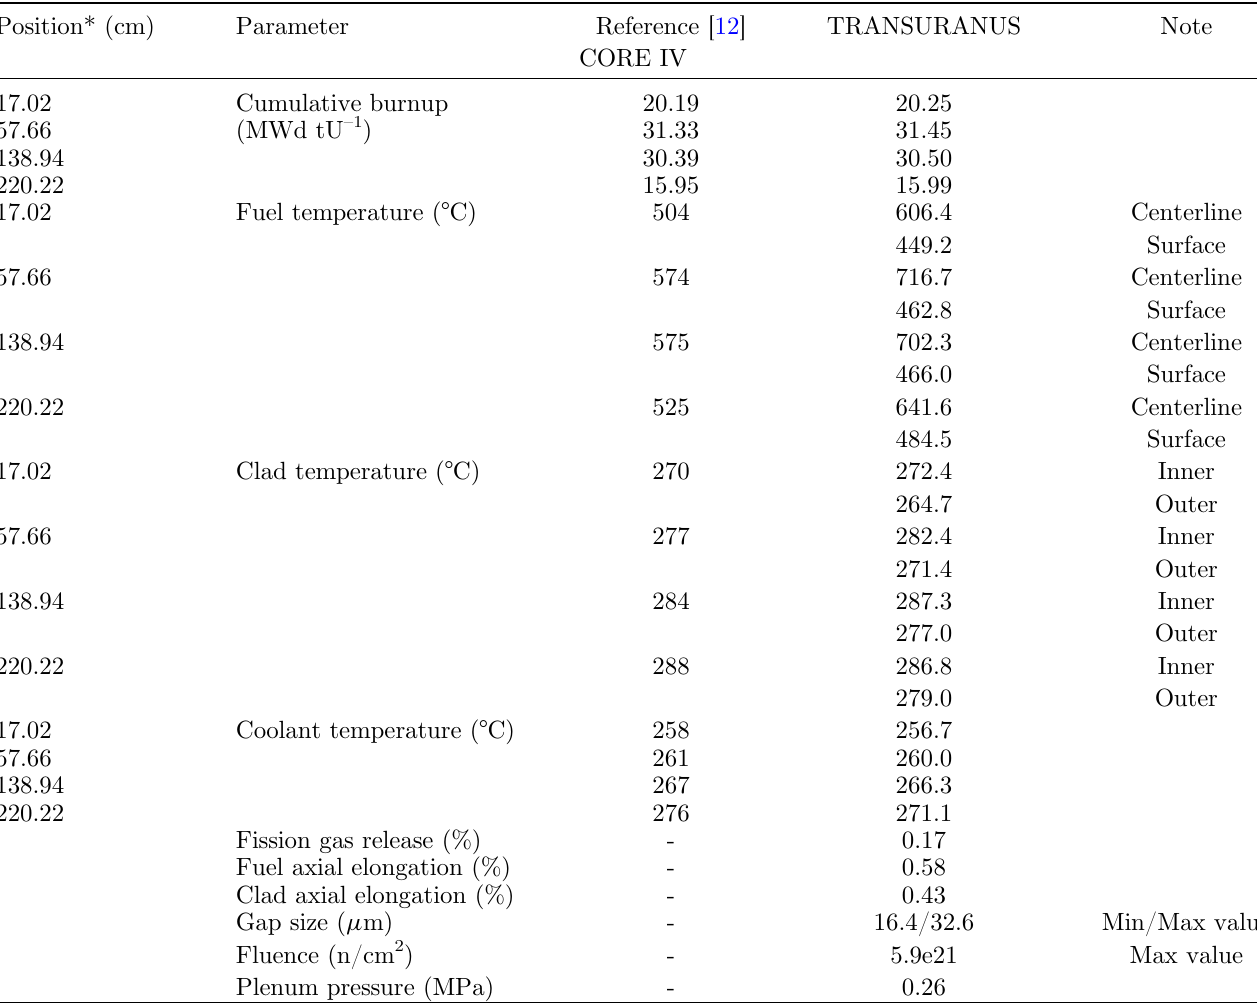
Table 5. Yankee Rowe E6-C-f6: comparison between reference and calculated data at the end of Core IV cycle. Position*